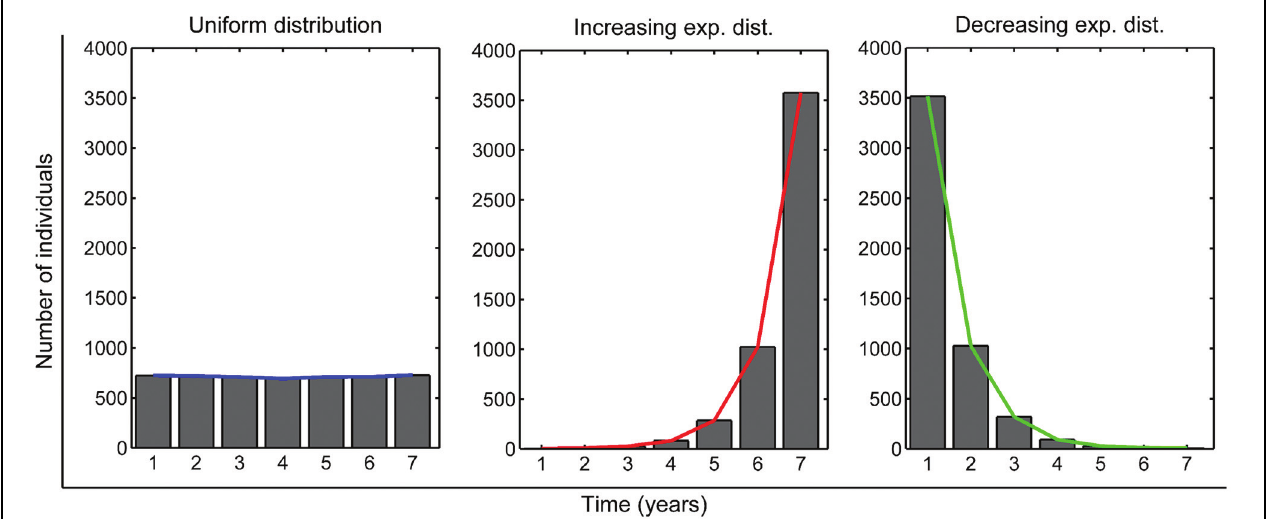
FIGURE 5 | Three infection time distributions (homogeneous, in blue; increasing exponential, in red; and decreasing exponential, in green) used as initial conditions in simulations, all corresponding to a population of 4,500 infected individuals.